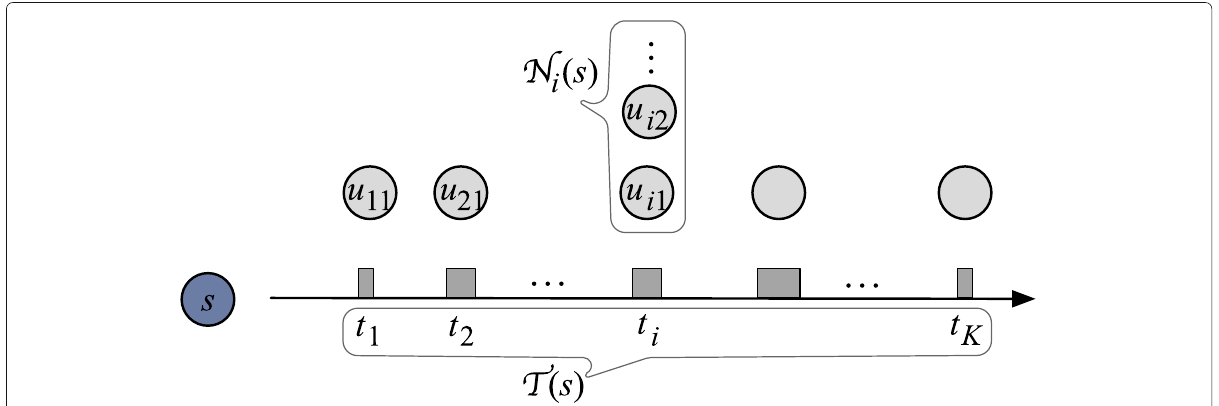
Fig. 2 Example of the single-hop transmission opportunity distribution for sender s